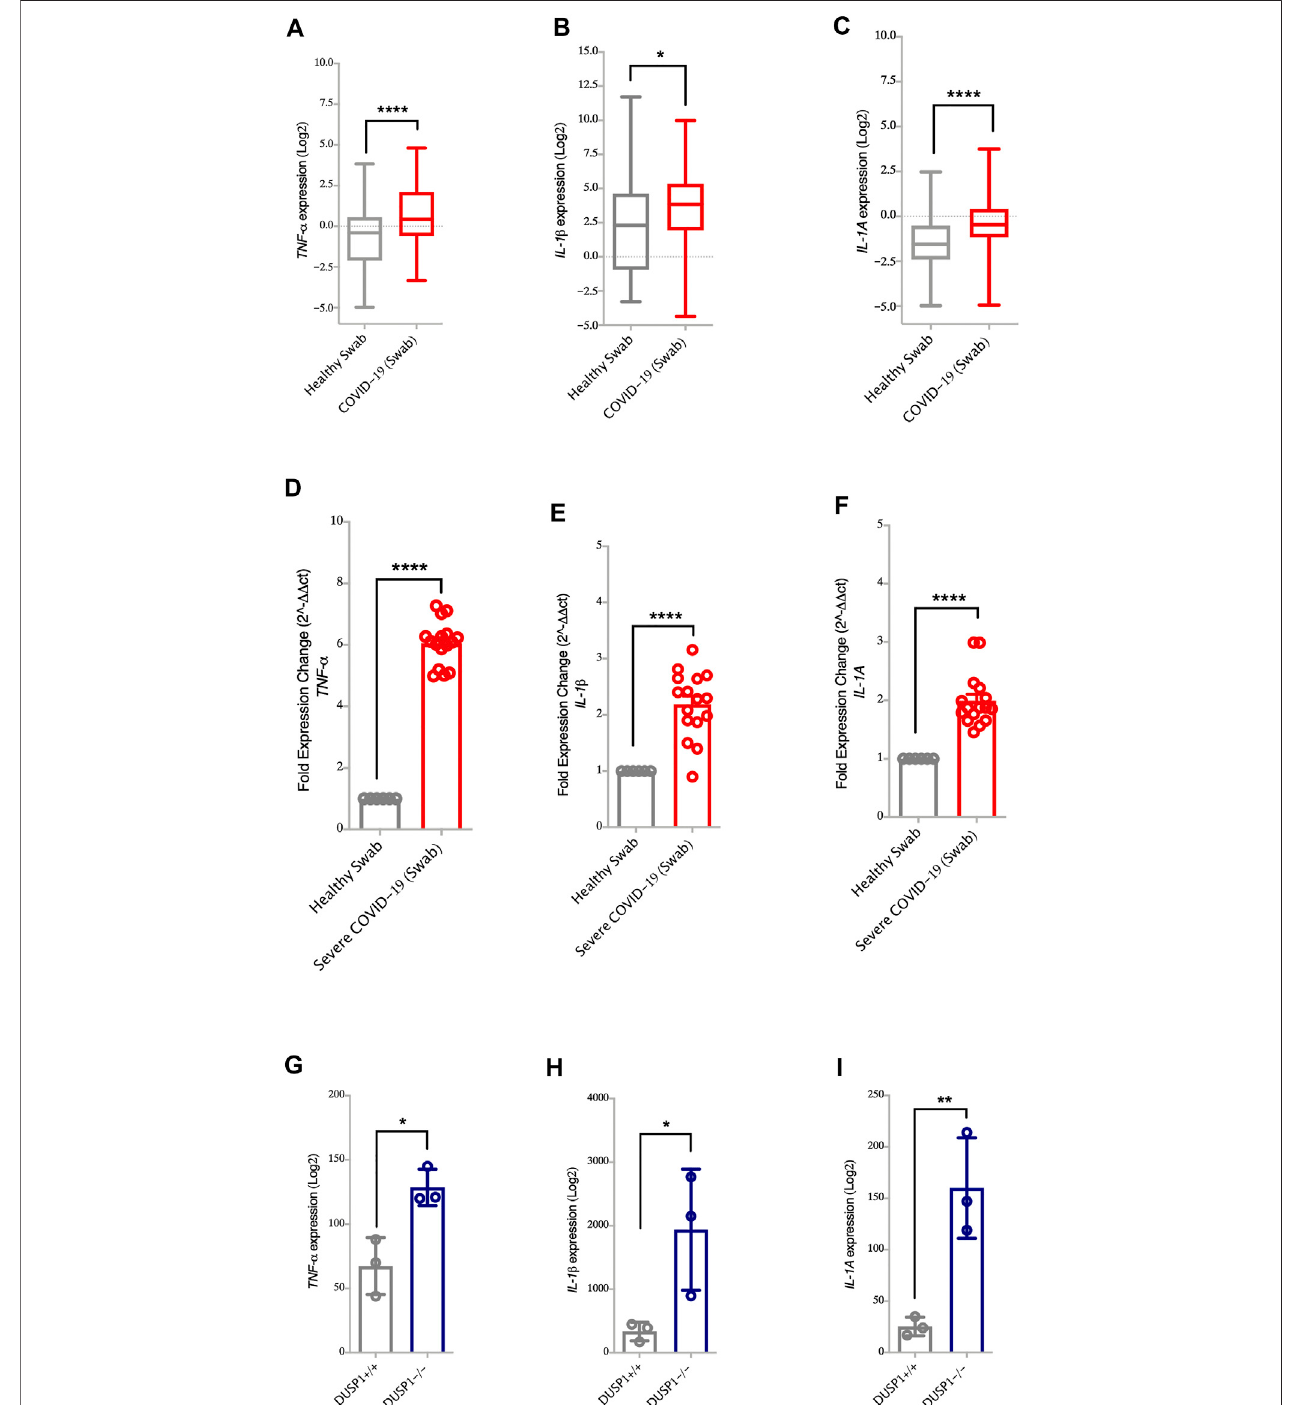
FIGURE 3 | Increased gene expression of MAPK associated pro-in fl ammatory cytokines in nasopharyngeal swabs of COVID-19 patients (A – C) Gene expression level of TNF- α , IL-1 β , and IL-1A in nasopharyngeal swabs fromm COVID-19 ( n (cid:1) 430) and healthy controls ( n (cid:1) 54) (Dataset GSE152075). Expression level of TNF- α , IL-1 β , and IL-1A is higher in nasopharyngeal swabs of COVID-19 patients as compared to healthy controls (D – F) Con fi rmation of gene expression level of TNF- α , IL-1 β , and IL-1A as measured by RT-PCR, in nasopharyngeal swabs from COVID-19 pateints ( n (cid:1) 16) and healthy controls ( n (cid:1) 6). Expression level of TNF- α , IL-1 β , and IL-1A ishigherinnasopharyngealswabsfromCOVID-19patientsascomparedtohealthycontrols (G – I) Geneexpressionlevelof TNF- α ,IL-1 β , and IL-1A inspleentissue of DUSP1 +/+ mice ( n (cid:1) 3) and DUSP1 − / − mice( n (cid:1) 3). Expressionlevel of TNF- α ,IL-1 β , and IL-1A ishigher in spleentissueof DUSP1 − / − ascompared to DUSP1 +/+ mice. Two-way comparison was done using t -test or Mann-Whitney U test, depending on the skewness of the data. * p < 0.05, ** p < 0.01, **** p < 0.0001.